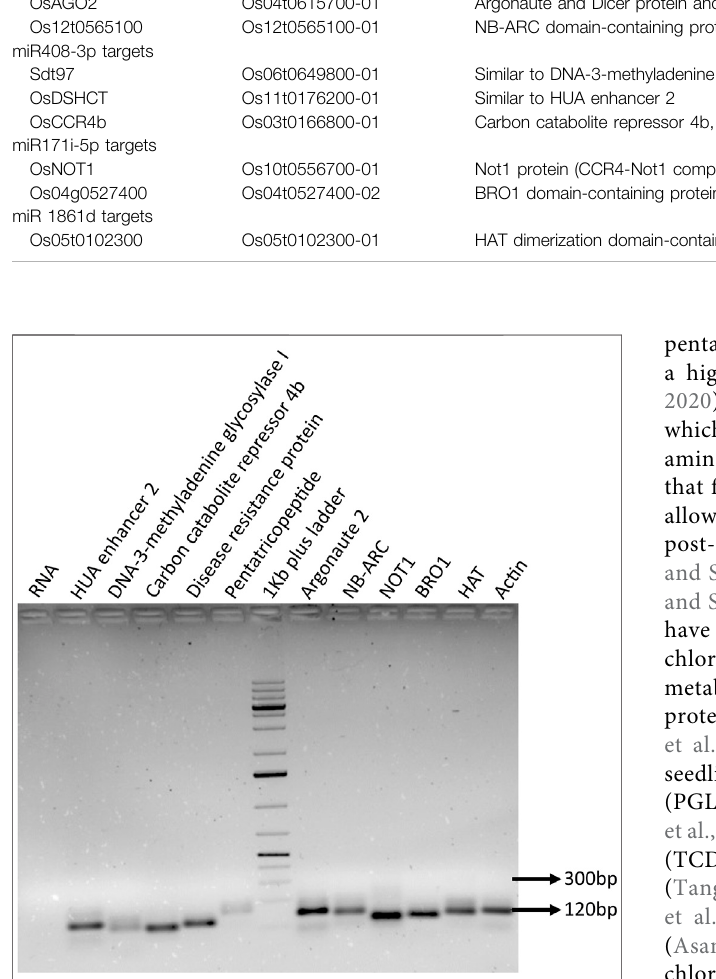
FIGURE 8 | PCR ampli fi cation of selected target genes. The miRNA targetgeneswereidenti fi edbyperforming insilico analysis,andspeci fi ctarget was selected based on the miRNA-binding ability and score. The speci fi c primers were designed for the selected genes, and primer quality and precise amplicon were ensured by performing RT-PCR along with negative RNA and internal control